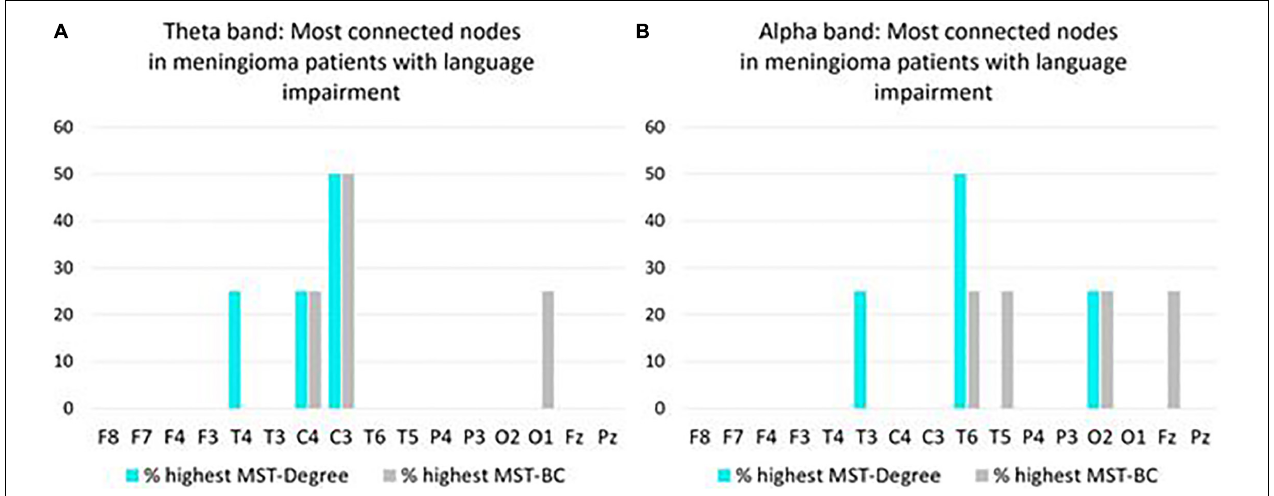
FIGURE 3 | Overview of most connected nodes in MST networks in the theta band (A) and in the alpha band (B) in pre operative meningioma patients with language impairment ( N = 4). For each node, the y -axis expresses the percentage of patients who have the highest Degree/Betweenness Centrality (BC) ranking for that node in their MST network. If a patient’s network has two or more nodes with a shared highest ranking, all shared highest rankings are included in the figure.